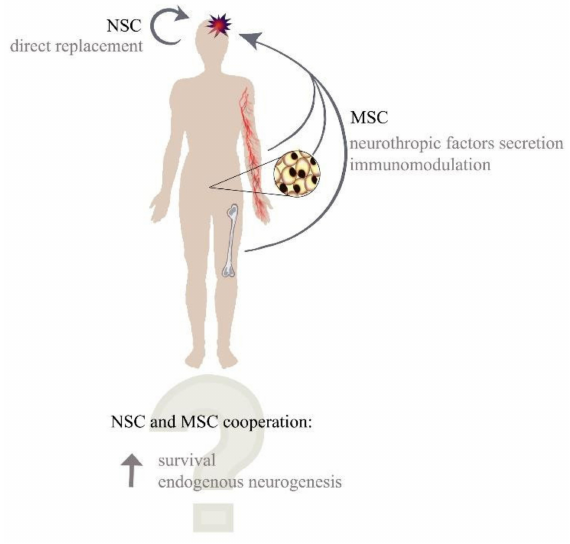
Figure 1. Potential abilities of MSC and NSC